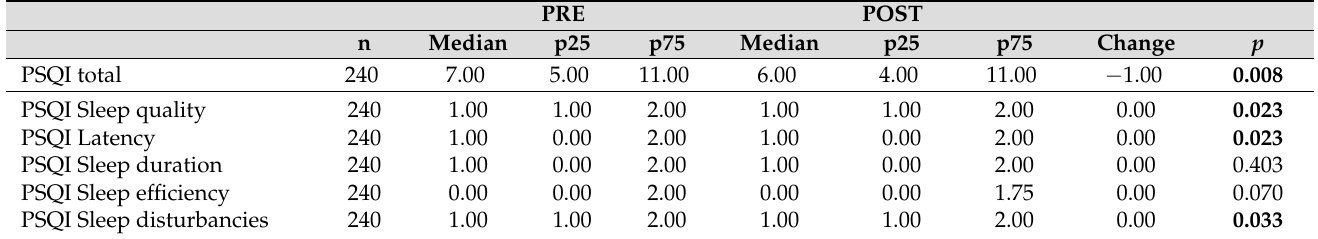
Table 2. Sleep quality, quality of life, anxiety, depression and functional capacity of subjects before and after the Multidisciplinary Cardiac Rehabilitation